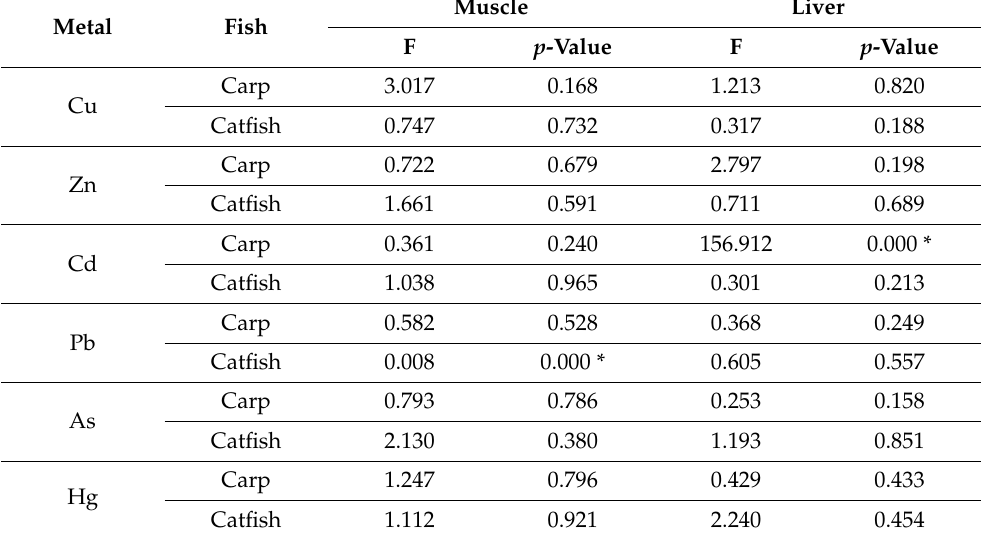
Figure 3. Zn accumulation in the experimental ( • ) and control groups ( carp, ( b ) muscle in catfish, ( c ) liver in carp, and ( d ) liver in catfish. Table 4. F-test to compare the variances of the experimental and control groups for carp and catfish, in muscle and